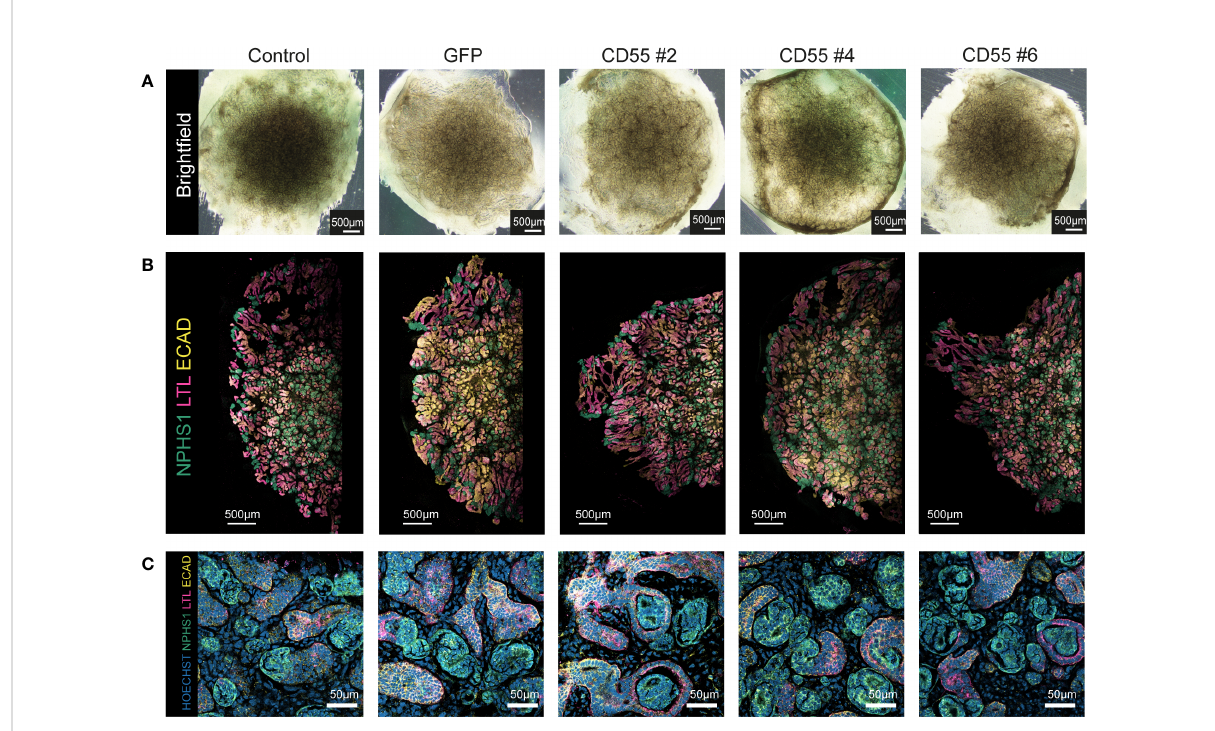
FIGURE 4 Modi fi ed iPSC-derived kidney organoids contain nephron structures upon differentiation. (A) Representative bright fi eld images of kidney organoids from unmodi fi ed iPSCs (control) and genetically modi fi ed iPSCs at day 7 + 14 of differentiation. (B) Representative fl uorescent images of half an organoid, with detection of NPHS1 (podocytes, green), LTL (proximal tubule, pink), and ECAD (distal tubule, yellow). (C) Representative images of a higher magni fi cation of the staining shown in (B) with additional detection of nuclei (Hoechst,